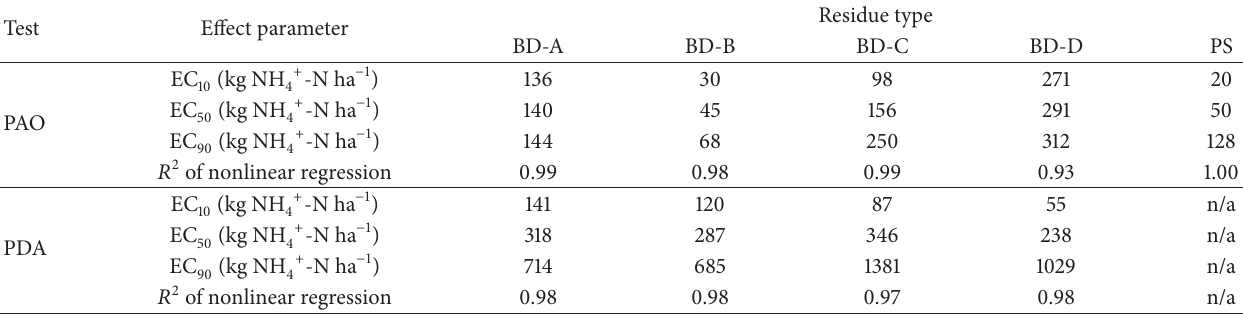
Table 6: Effect concentrations lowering potential ammonia oxidation rate (PAO) and potential denitrification activity (PDA) in the soil by , EC , and EC ) in response to addition of four types of biogas digestates (BD-A, BD-B, BD-C, and BD-D) and pig 10, 50, and 90% (EC 10 50 90 slurry (PS).